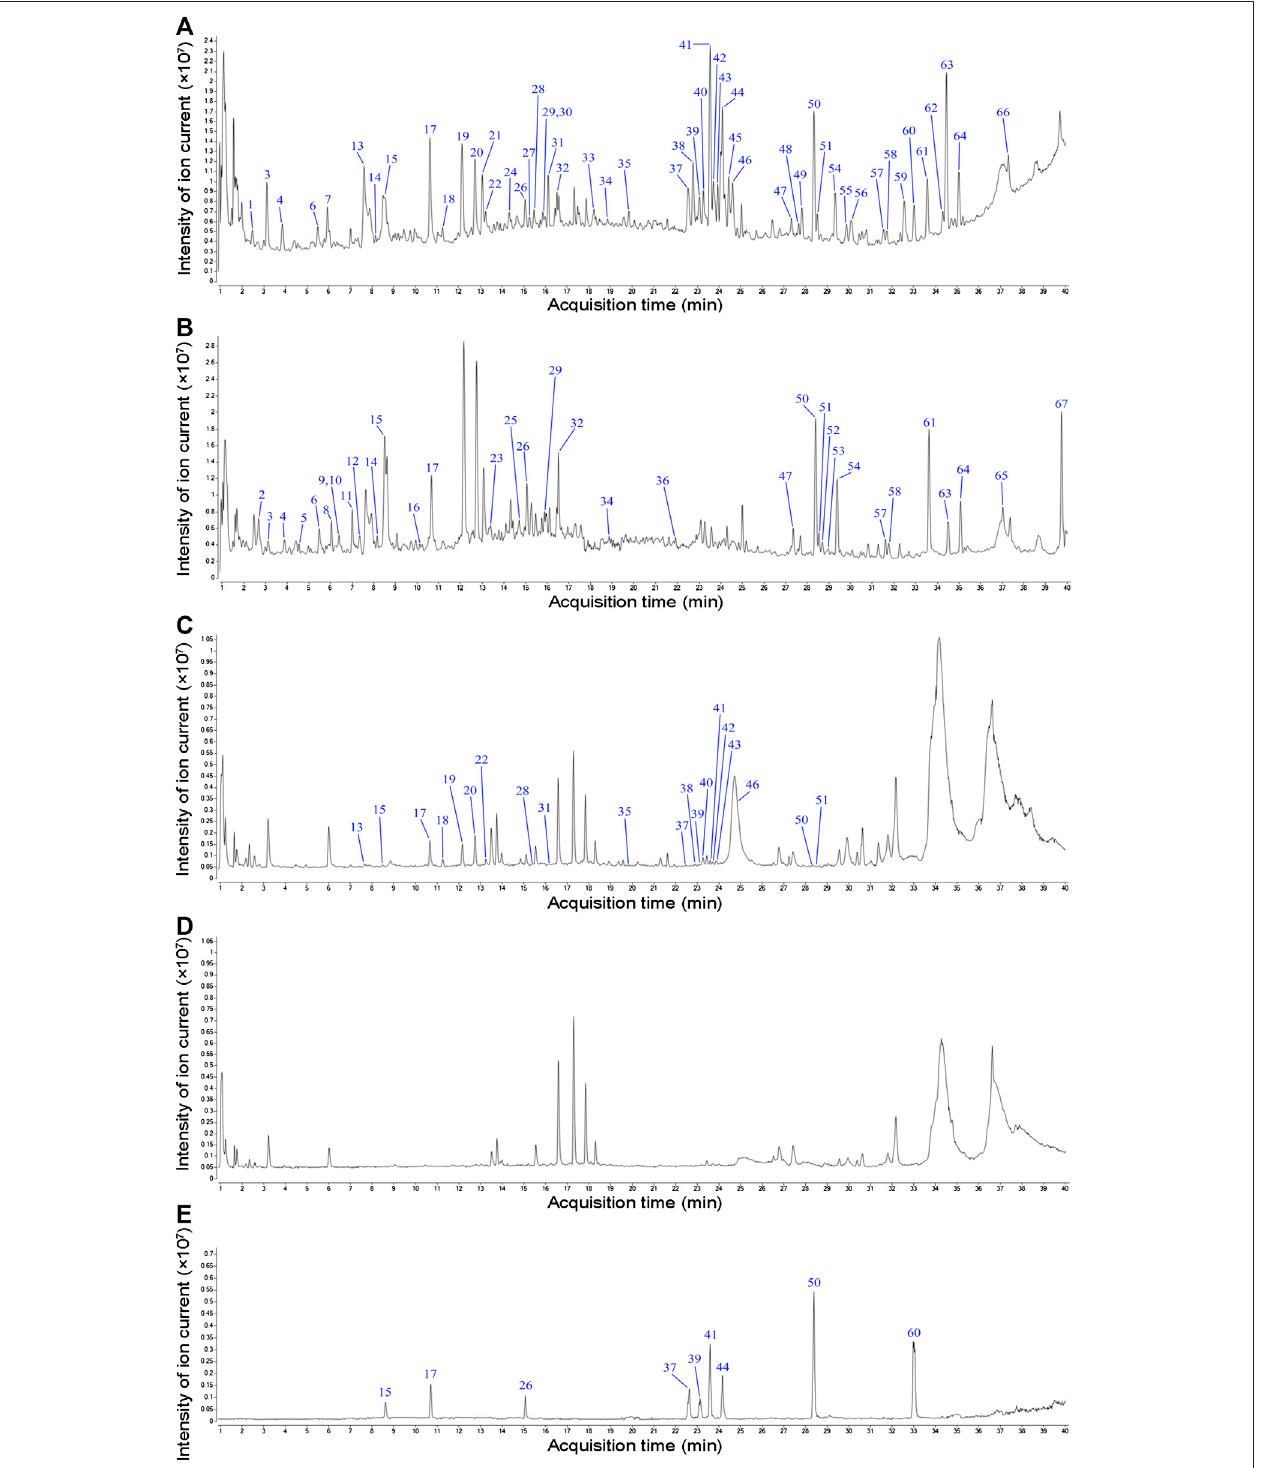
FIGURE3| Totalionchromatograms(TIC)fromBSHXdecoction,medicatedserum,non-medicatedserum,andstandardsubstances. (A) TICofBSHXdecoction inpositivemode. (B) TICofBSHXdecoctioninnegativemode. (C) TICofmedicatedseruminpositivemode. (D) TICofnon-medicatedseruminpositivemode. (E) TICof standard substances. Peak numbers correspond to compound numbers (see Supplementary Table S2 ).